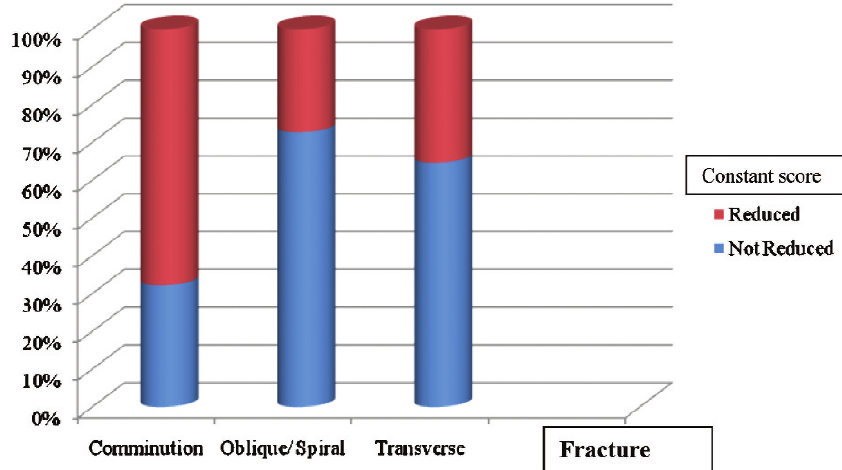
Figure 2 - Clavicle fracture type and Constant score.